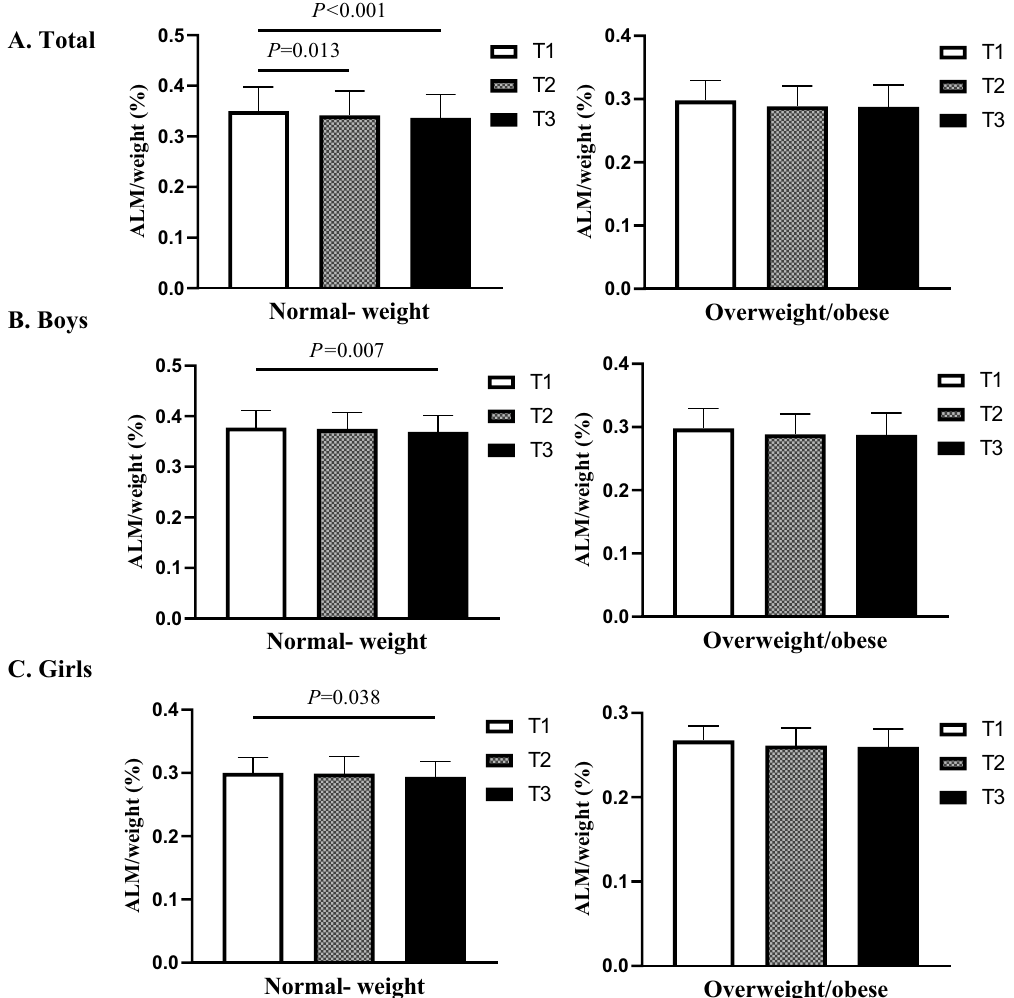
Figure 1. ALM/weight in total population ( A ), boys ( B ) and girls ( C ) according to the TyG index tertile in the normal- weight and overweight/obese groups. ALM appendicular lean mass, TyG index triglyceride-glucose index .